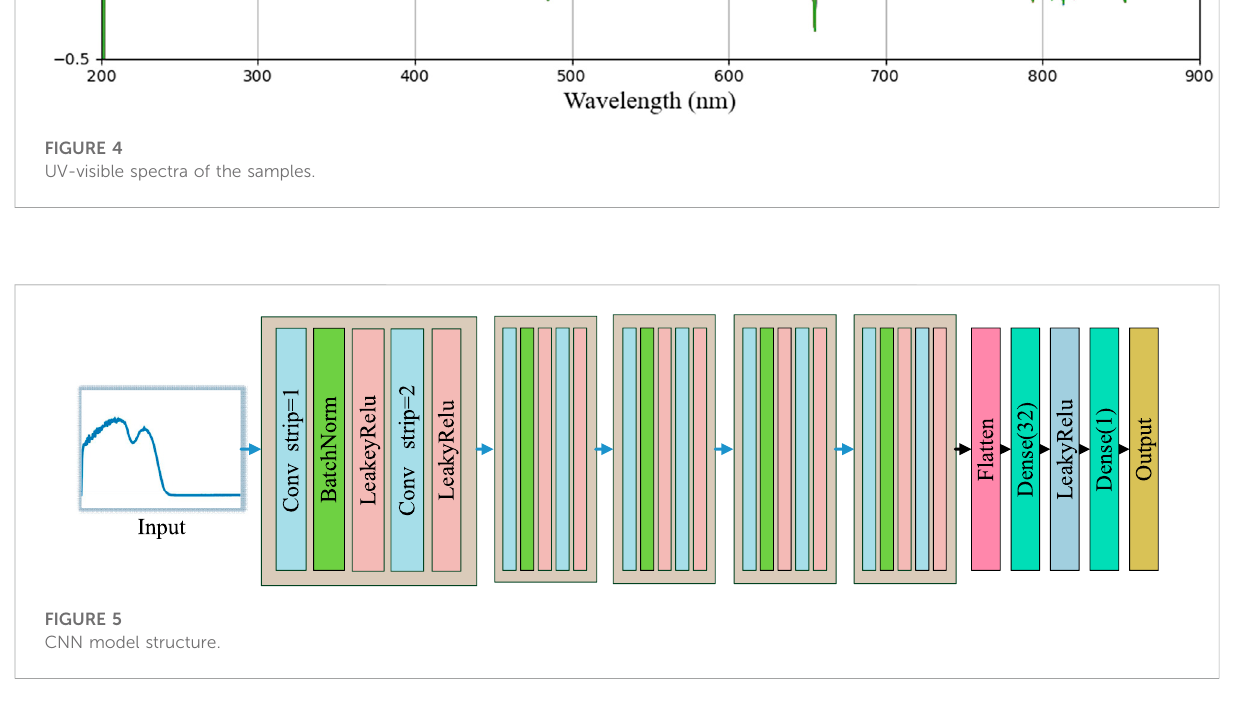
FIGURE 4 UV-visible spectra of the samples.